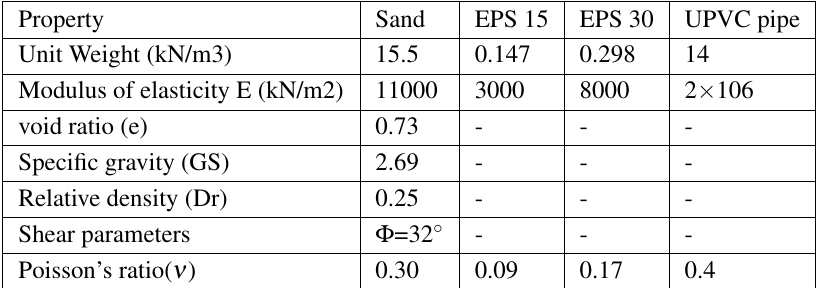
Table 1. properties of